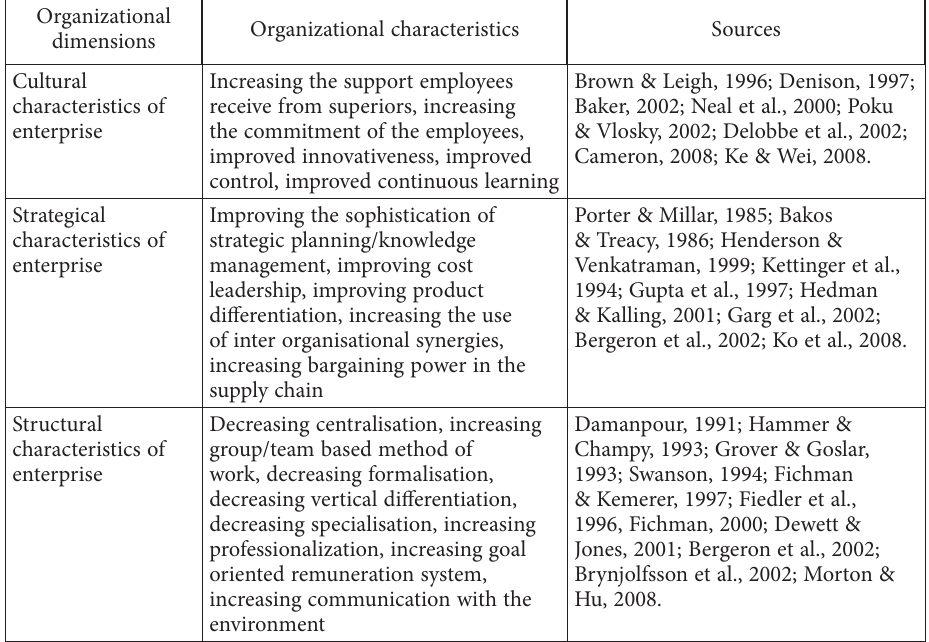
Table 1. Required/complementary organizational characteristics for successful investments in enterprise software products (ERP, CRM, …) in USA Organizational